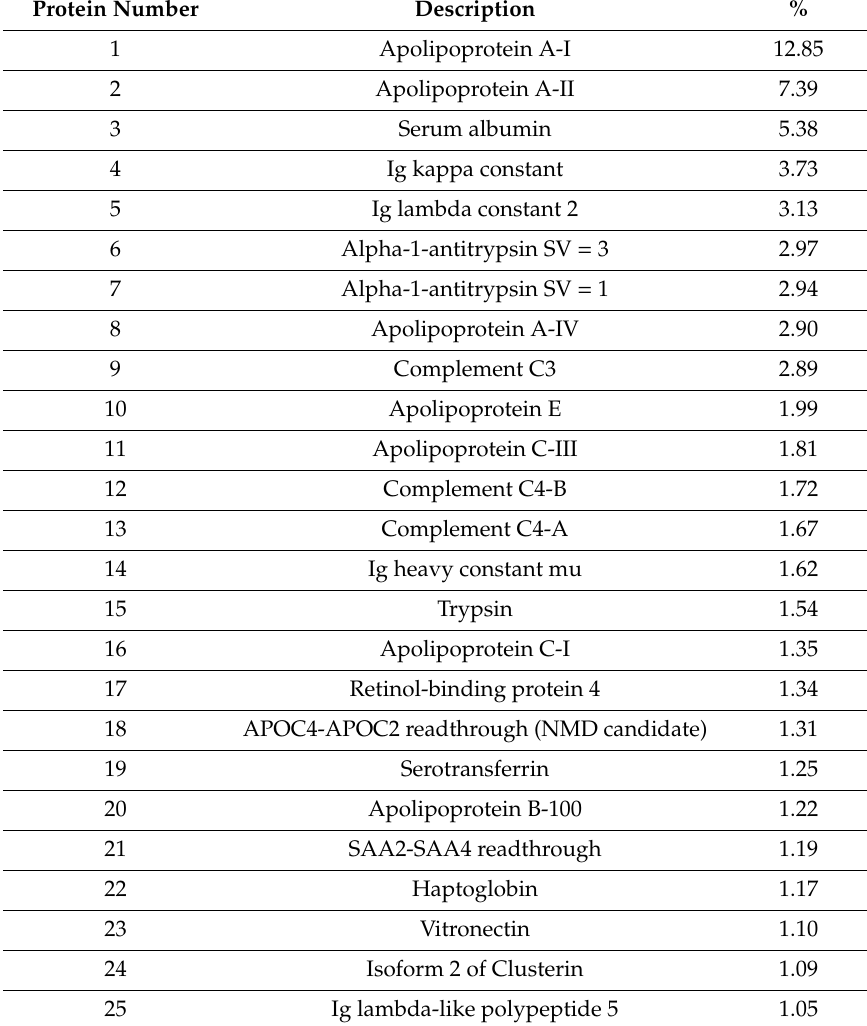
Table2. Top25most-abundantproteinspresentintheproteincoronasurroundingC 3 (C 16 His) 2 / MOG-siRNA lipoplexes surfaces at α = 0.2 and ρ eff =